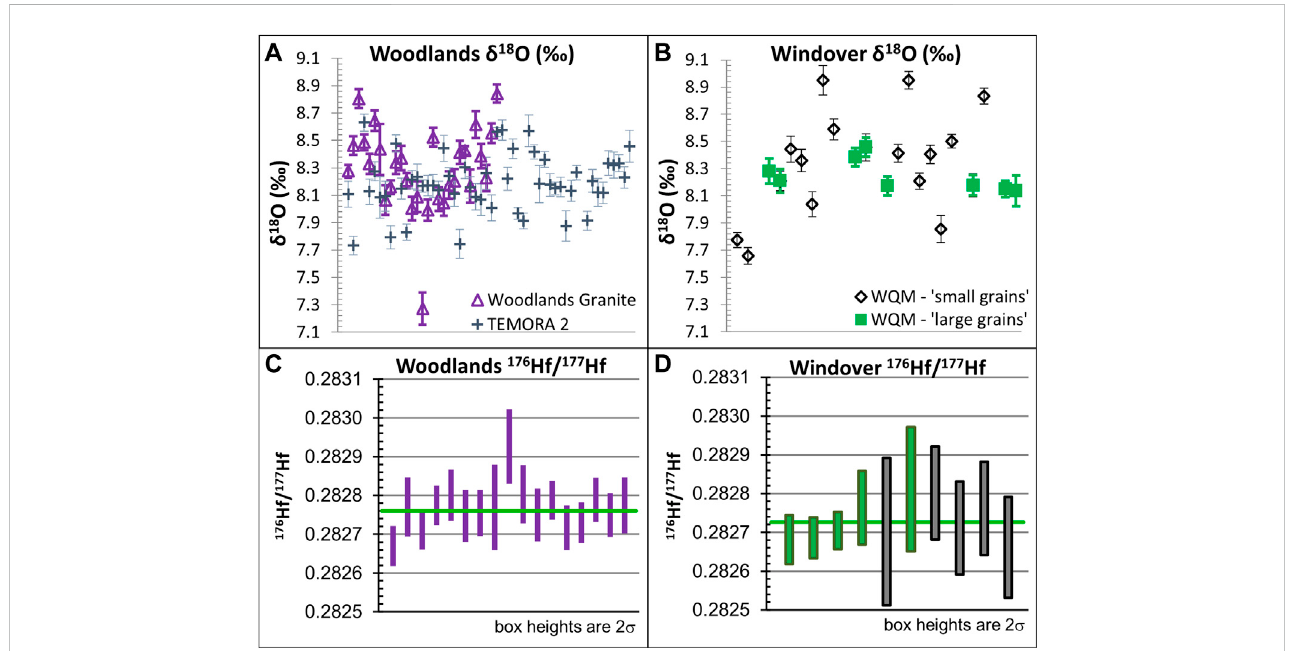
FIGURE 5 (AandB) δ 18 O( ‰ )valuesofthezirconsfromtheWoodlandsGranite(includingoneoutlier,notedintext)andWindoverQuartzMonzodiorite(oneoutlier included and one off scale). Also shown are the 52 analyses of TEMORA 2, used as the calibration reference material for these analyses with a mean δ 18O of 8.2 ‰ . (C and D) The 176 Hf/ 177 Hf values of the zircons from the Woodlands Granite and Windover Quartz Monzodiorite (both age populations — large grains in green). Plots were generated using Isoplot of Ludwig